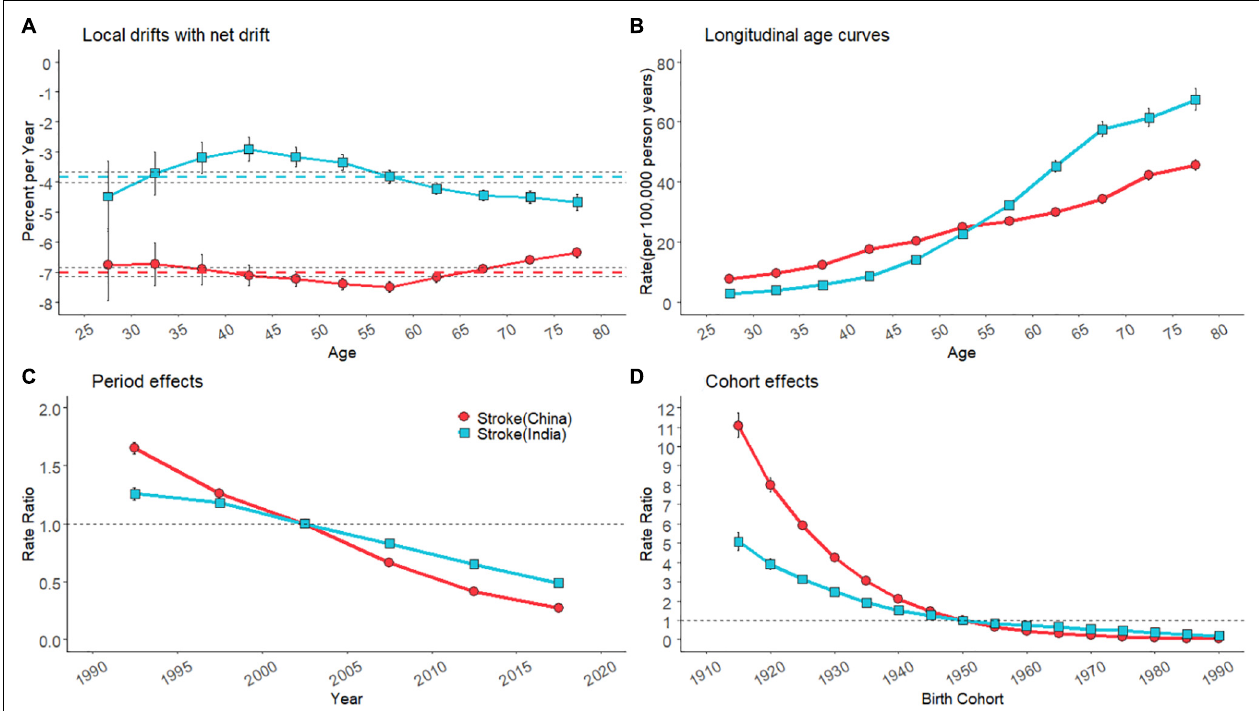
FIGURE 2 | Parameter estimates of age, period, and cohort effects on HAP-attributable stroke mortality rate in China and India from 1990 to 2019. (A) , local drifts with net drifts for HAP-attributable stroke mortality. Net drifts were depicted as colored dashed lines with black dashed lines representing their 95% CIs. Error bars represented the 95% CIs for the local drift values (some were too narrow to show). (B) , fitted longitudinal age curves of HAP-attributable stroke mortality (per 100,000 person-years) and the corresponding 95% CIs. (C) , the rate ratios (RRs) of each period compared with the reference (2000–2004) adjusted for age and nonlinear cohort effects and the corresponding 95% CI. (D) , the RRs of each cohort compared with the reference (cohort 1950–1954) adjusted for age and nonlinear period effects and the corresponding 95%